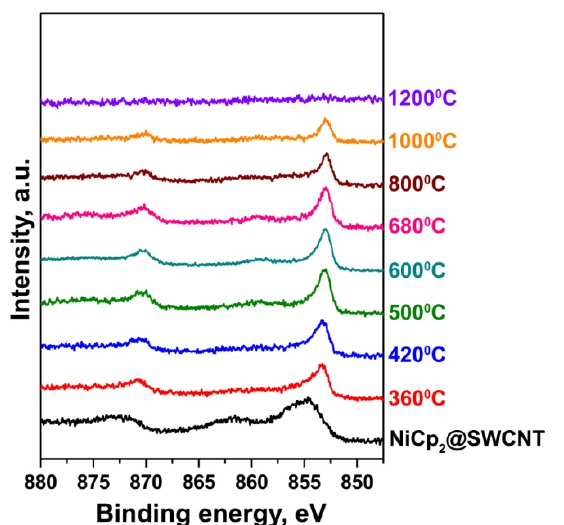
Figure 2. The Ni 2p XPS spectra of nickelocene-filled SWCNTs and samples annealed at temperatures between 360 and 1200 ° C for 2 h.